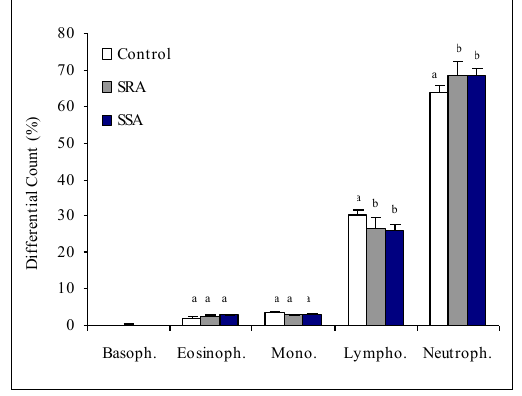
Fig. (5): Differential WBC count among SSA (n=28) and SRA (n=27) patients. Values are (mean ± SEM). Non-identical superscripts (a, b) considered significant, P<0.05 analyzed by